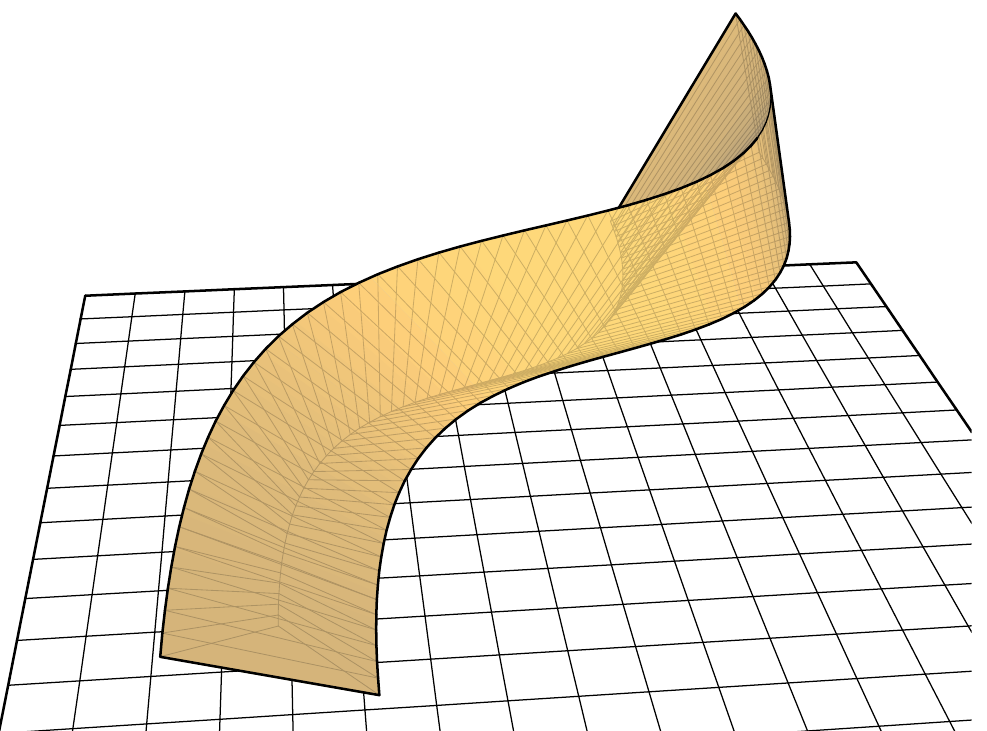
Figure 9. Rigid tube consisting of three ruled surfaces between homothetic spline